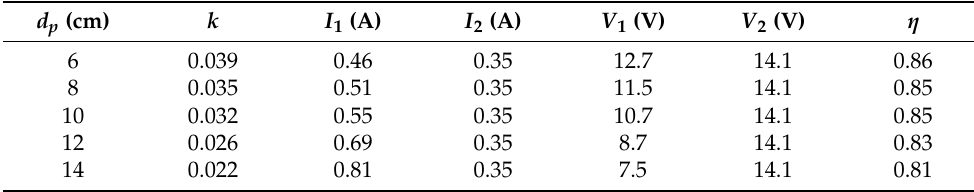
Table 2. Electrical quantities vs. implantation depth d p for θ = 30 ◦ .